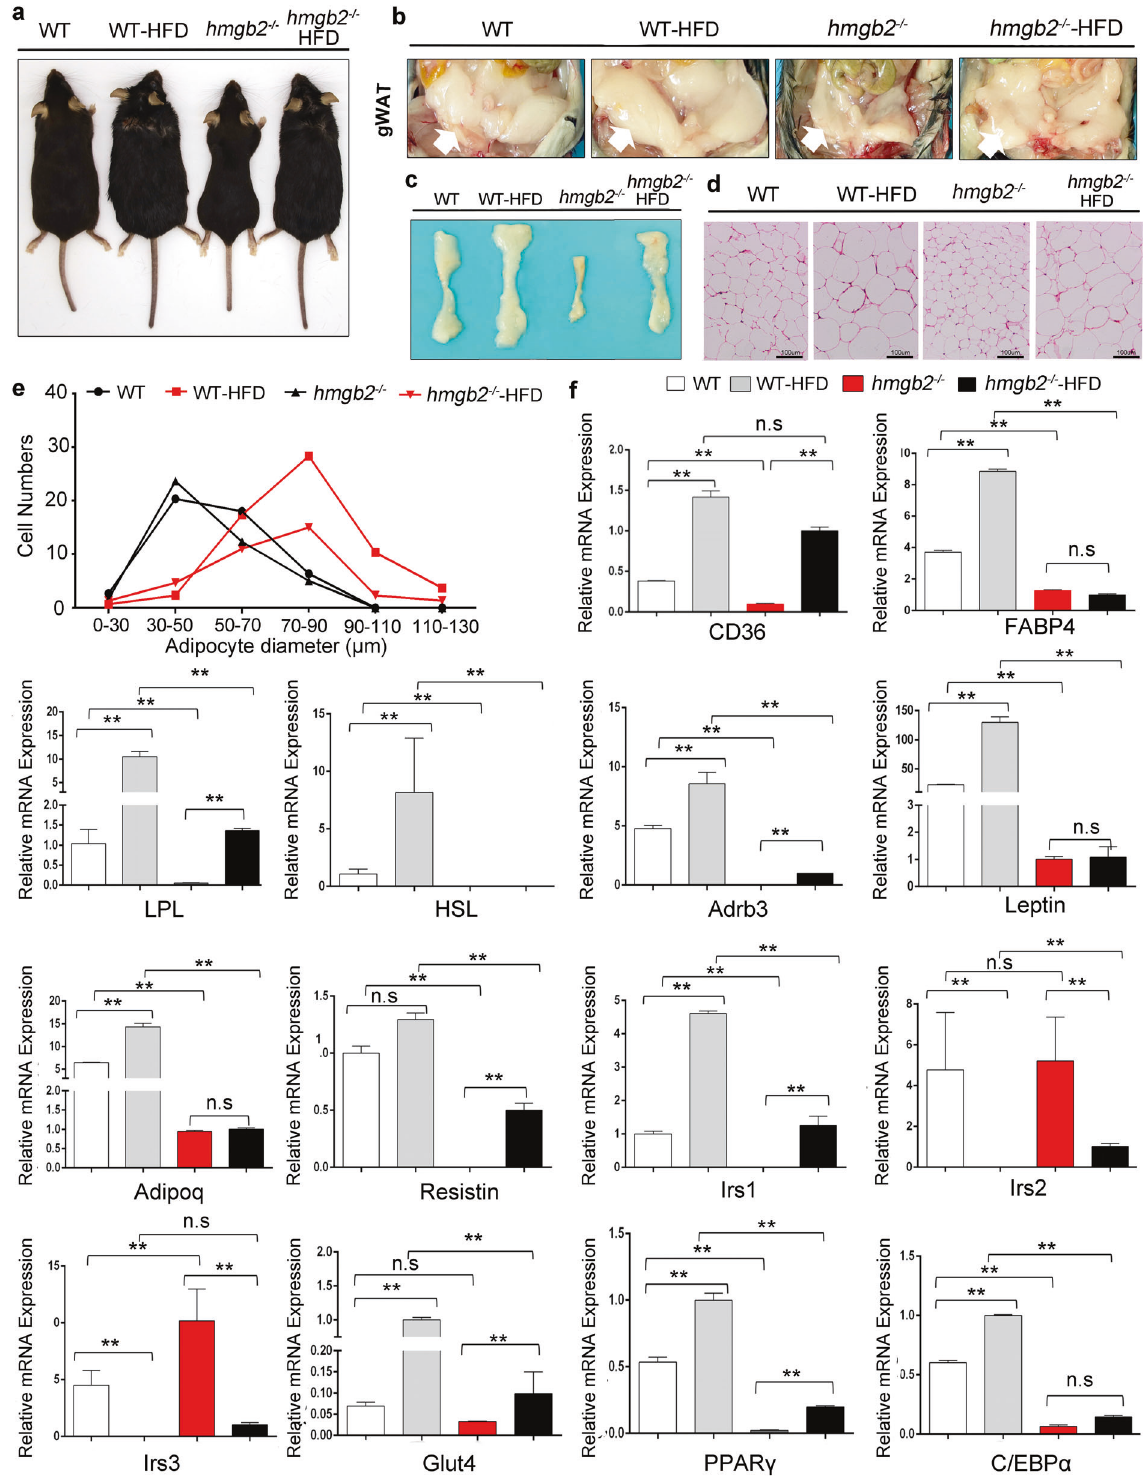
Fig. 4 HFD enhances adipogenic ability of hmgb2 − / − mice but at a lower rate. a Representative comparison images of 4 different groups. b , c Abdominal WAT and ingWAT images of four mice groups. d H&E staining of ingWAT slides. e Statistical data of adipocyte size measurements from four groups. f qPCR of adipogenic genes of four mice groups. (four groups of mice: WT (chow diet), hmgb2 − / − (chow diet), WT HFD, and hmgb2 − / − - HFD. a – d : male; age: 20 weeks old; n = 5, f : mean values ± s.e.m. ** P < 0.01).